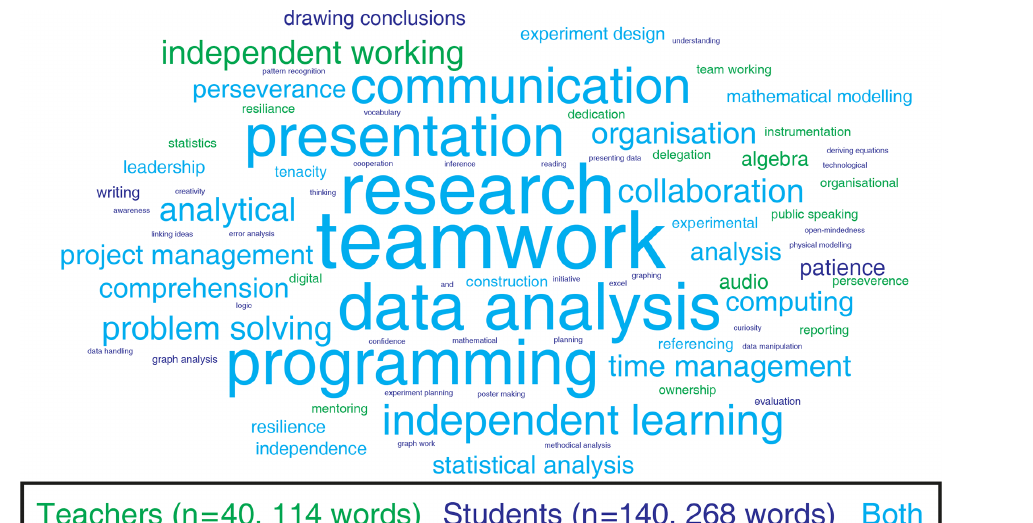
Figure 2. Word cloud of skills developed by students. Colours indicate words identified by students (blue), teachers (green), or both (cyan). Students and teachers have been given equal total